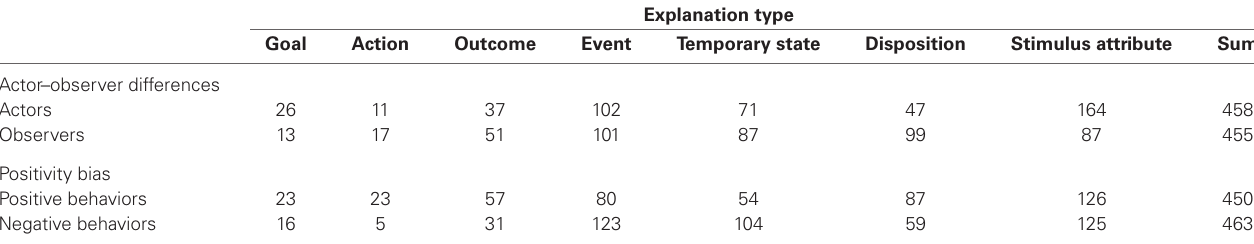
Table 2 | Actor–observer difference (top) and positivity bias (bottom) in free-response explanations (Experiment 1): distribution of free-response explanations across explanation